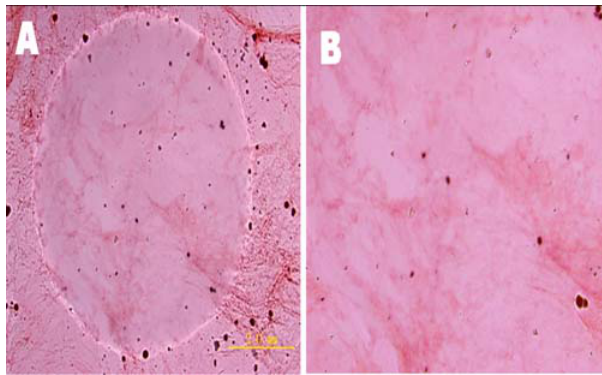
Figure 12. Optical microscopy images of d-EAK16 membranes. The colorless membranous structure was formed in phosphate-buffered saline and transferred to a glass slide. It can be seen by the naked eye when stained with Congo red. A) At 100 magnifications, the circular region is the membrane in the water and the rest is the dry membrane in the air at 20 u C, B) at 200 magnifications, the membranes in water of A).